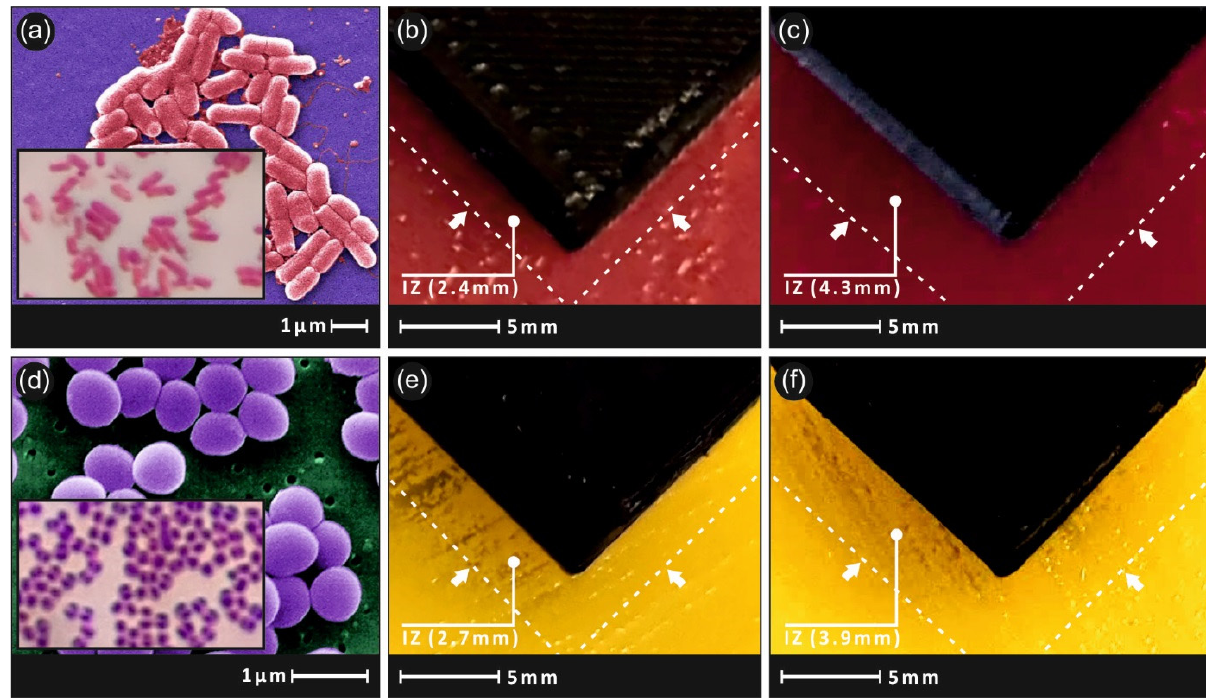
Figure 12. Agar well diffusion method pictures after 24 h culture showing the Inhibition Zone (IZ) of ( a ) Escherichia coli bacteria against PLA/CB (5.0 wt.%) ( b – d ) and Staphylococcus aureus against PLA/CB (5.0 wt.%) ( e , f ).